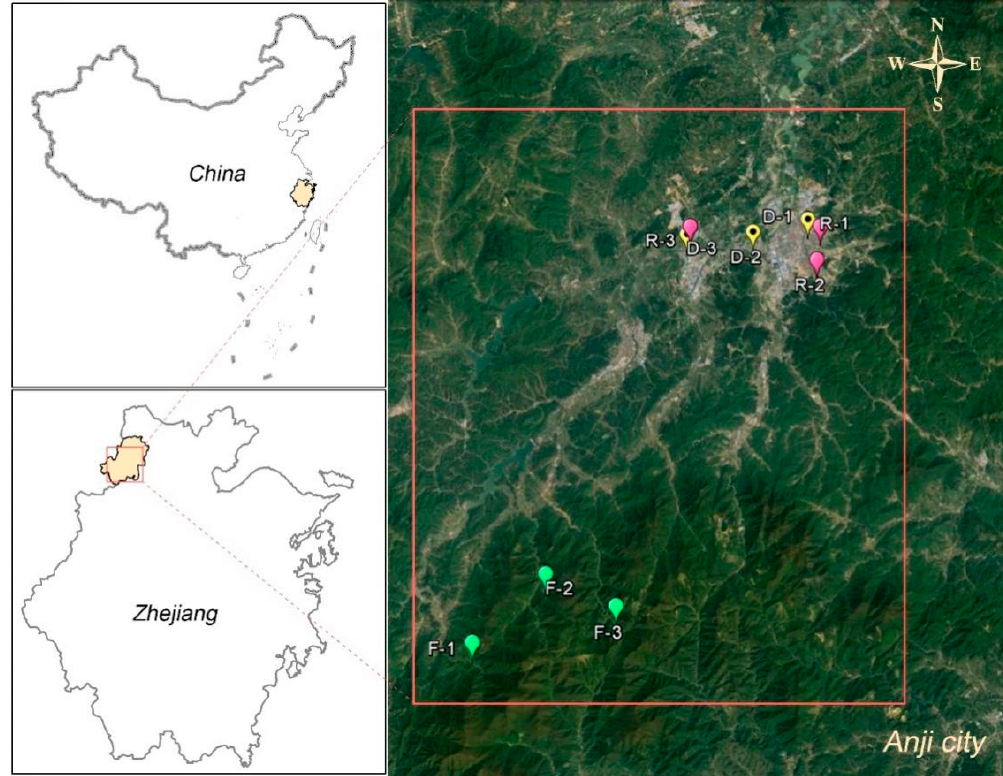
Figure 1. Location of the sampling sites within the Anji City Region, People's Republic of China (PRC), containing three degraded urban rivers (D), three restored rivers (R) and three Forested rivers (F). The three forest streams (F) were upstream from Anji City; the three restored rivers (R) and the three degraded urban rivers (D) were downstream of the forest ones.